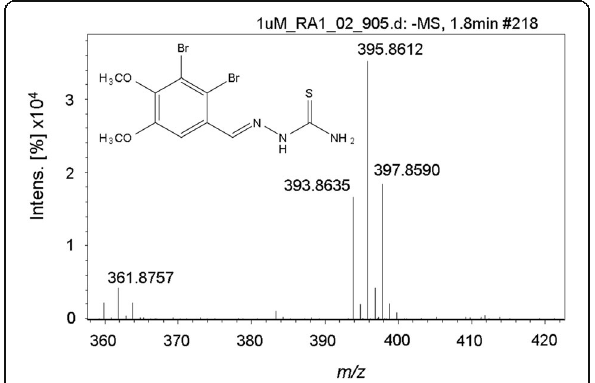
Fig. 1 Structure and exact mass of BTH in negative mode